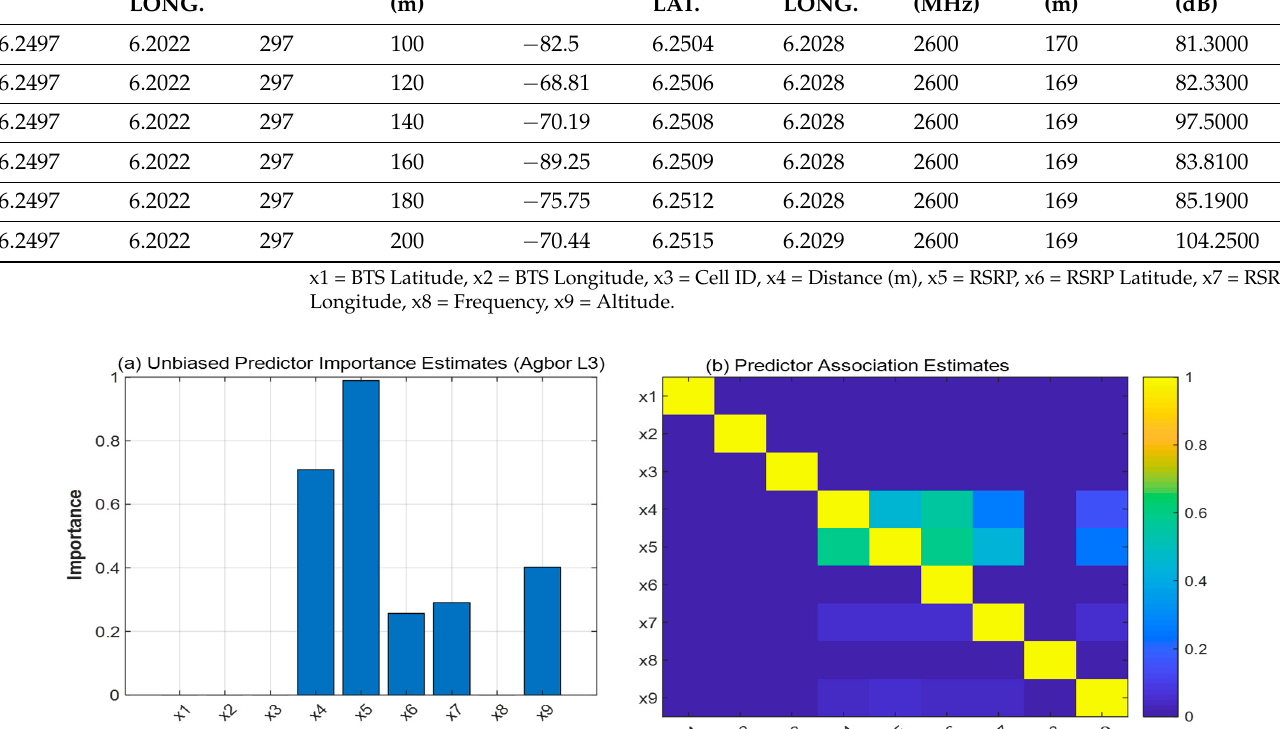
Table 1. The acquired signal dataset and the consistent features in one of the studied locations.